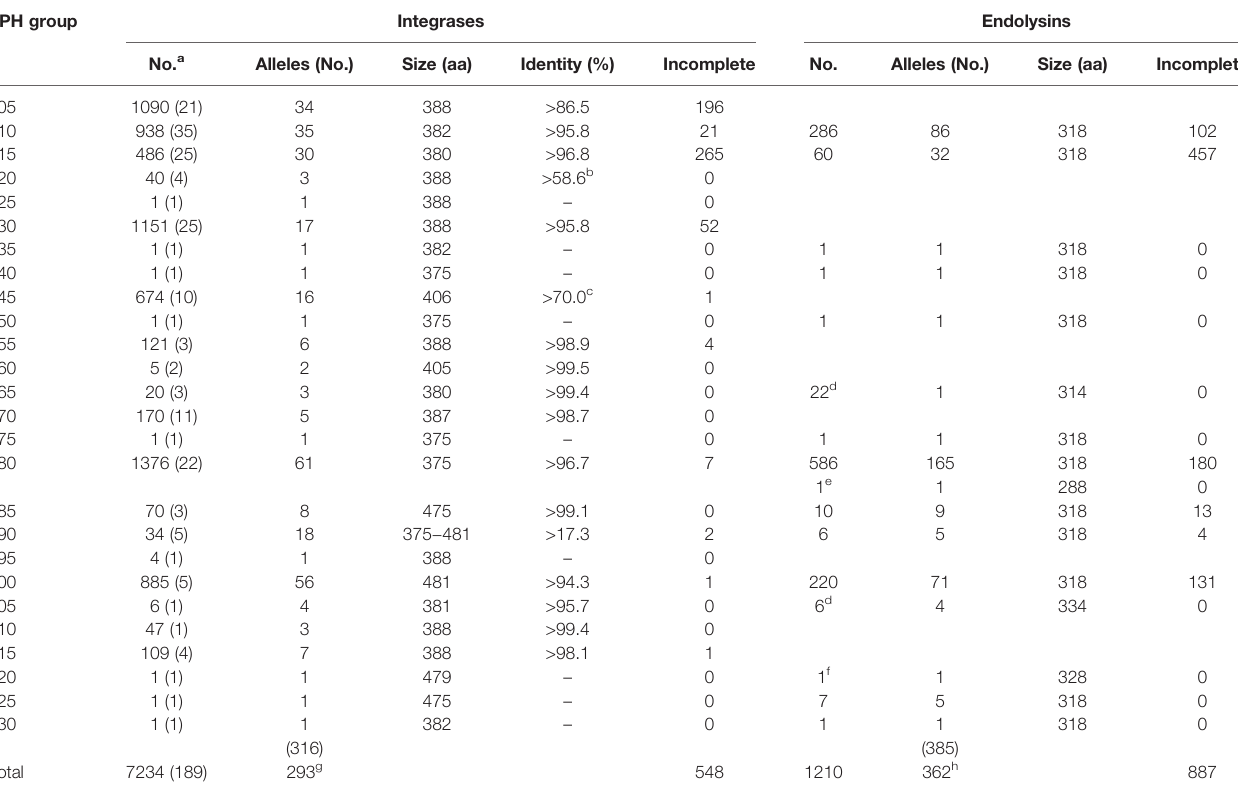
TABLE 1 | Number and distribution of integrases and endolysins in the pneumococcal prophages (PPHs)